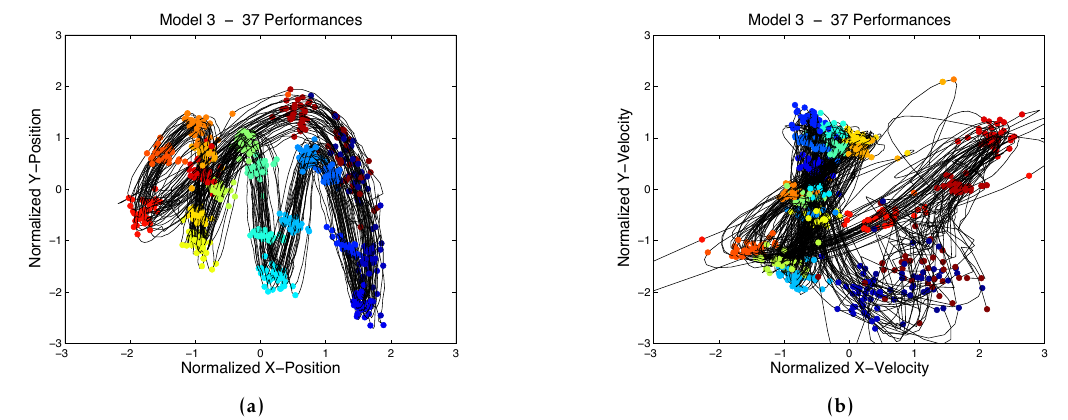
Figure 6. HMM key points for all basic gestures and their positional